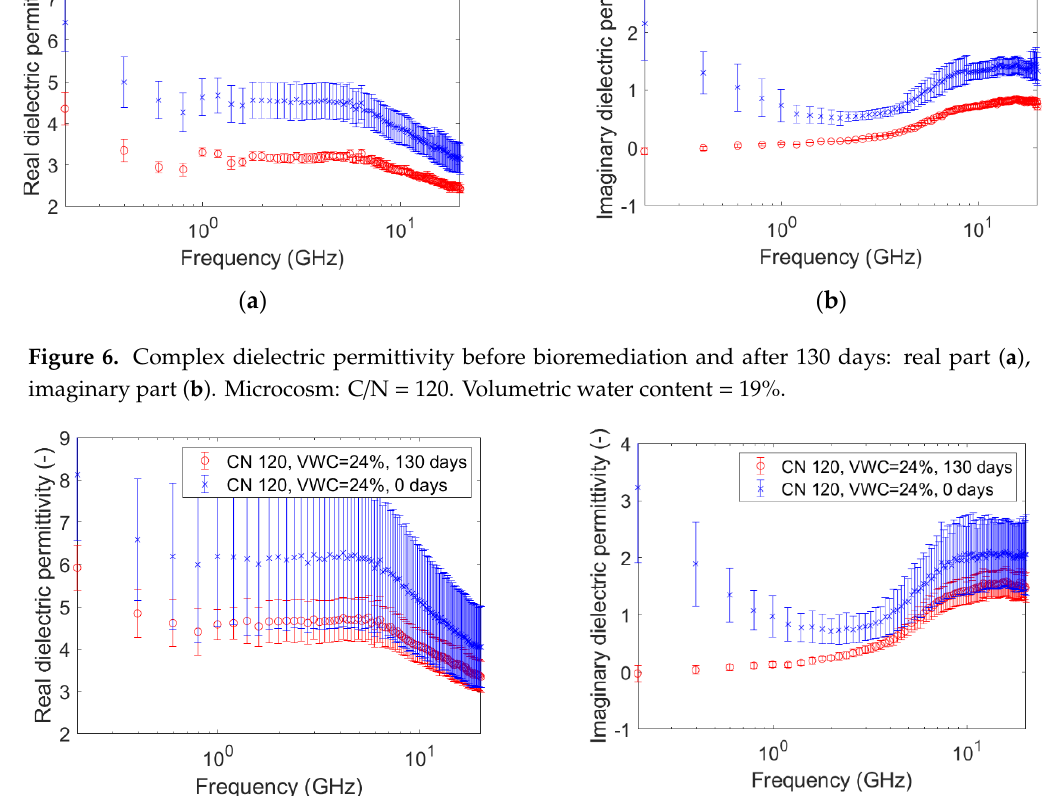
Figure 7. Complex dielectric permittivity before bioremediation and after 130 days: real part ( a ), imaginary part ( b ). Microcosm: C/N = 120. Volumetric water content = 24%.